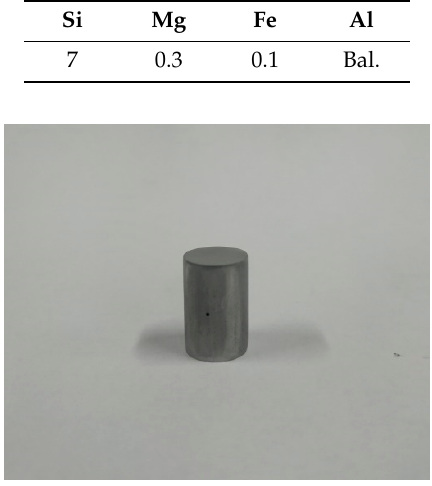
Figure 1. Specimen for thermal compression test.